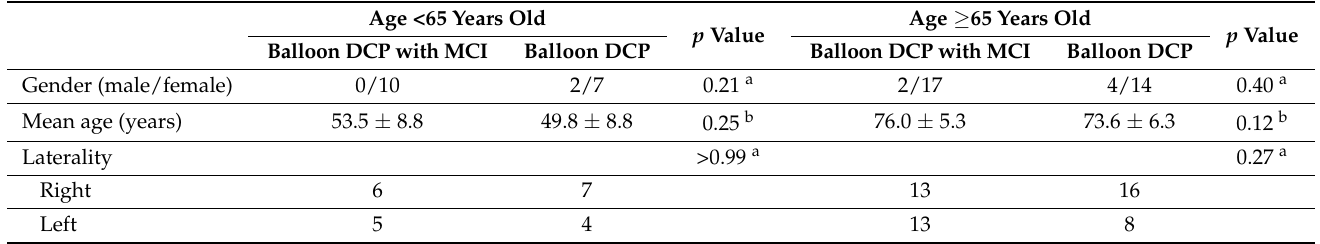
Table 3. Demographic data in patients in balloon DCP combined with pushed-type MCI group and balloon DCP alone group for patients younger than 65 years old and aged at least 65 years